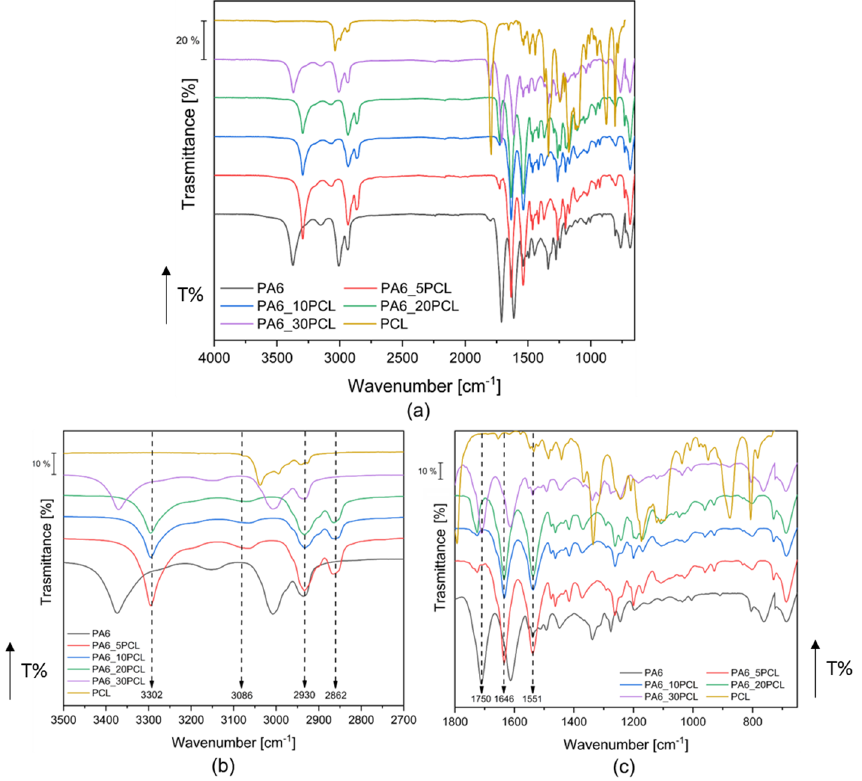
Figure 6. ATR − FTIR spectra of the prepared PA6/PCL blends. ( a ) Full spectra, ( b ) spectra in the region 3500–2700 cm − 1 , and ( c ) spectra in the region 1800–650 cm − 1 .